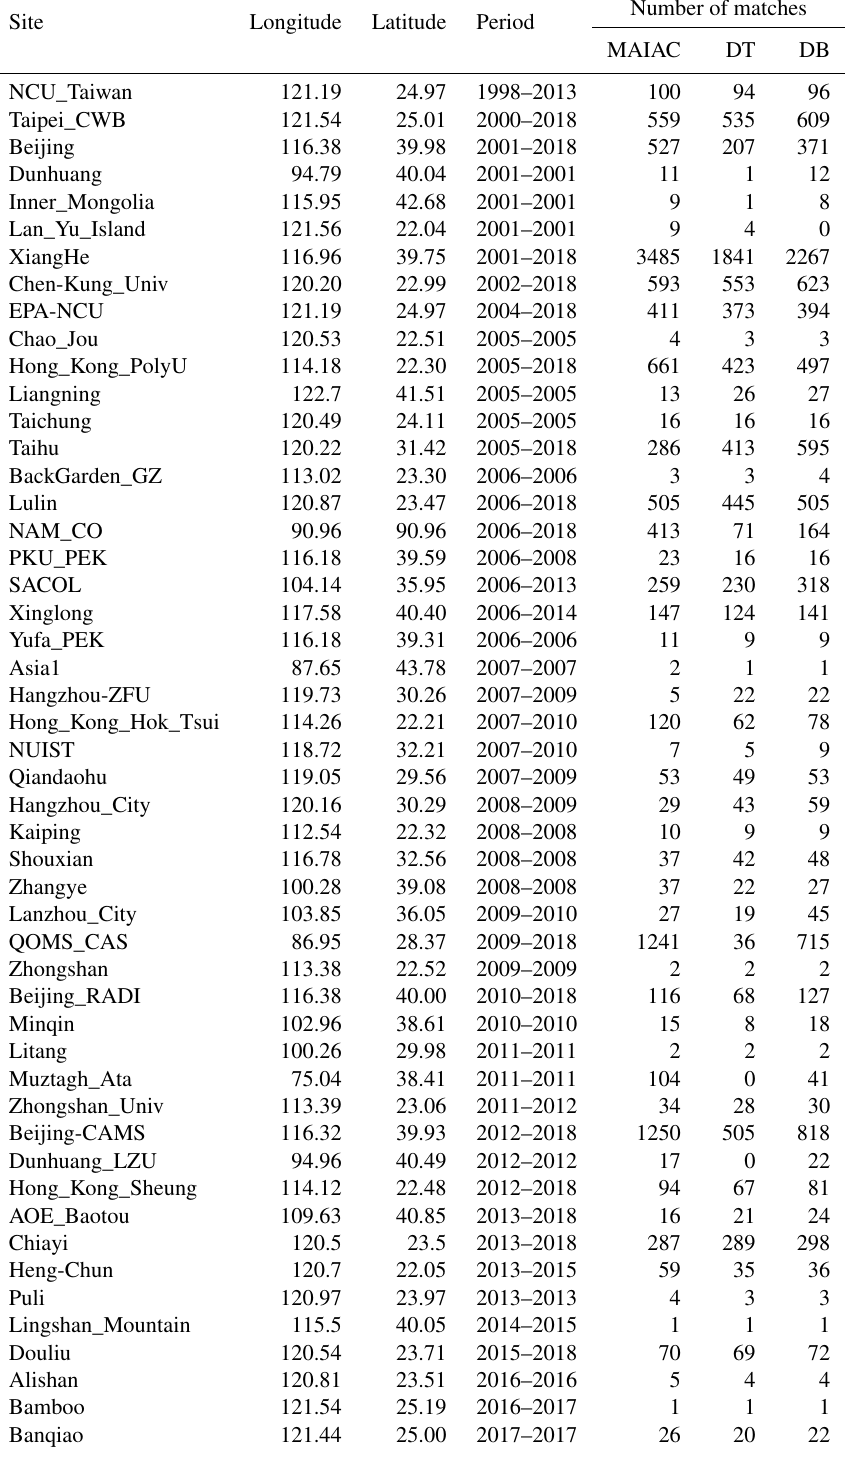
Table 1. Selected AERONET sites used in this study. The number of the match column statistics matches the number between the satellite observations before the QA filter and the ground AERONET observations in the selected spatiotemporal window presented in Sect.